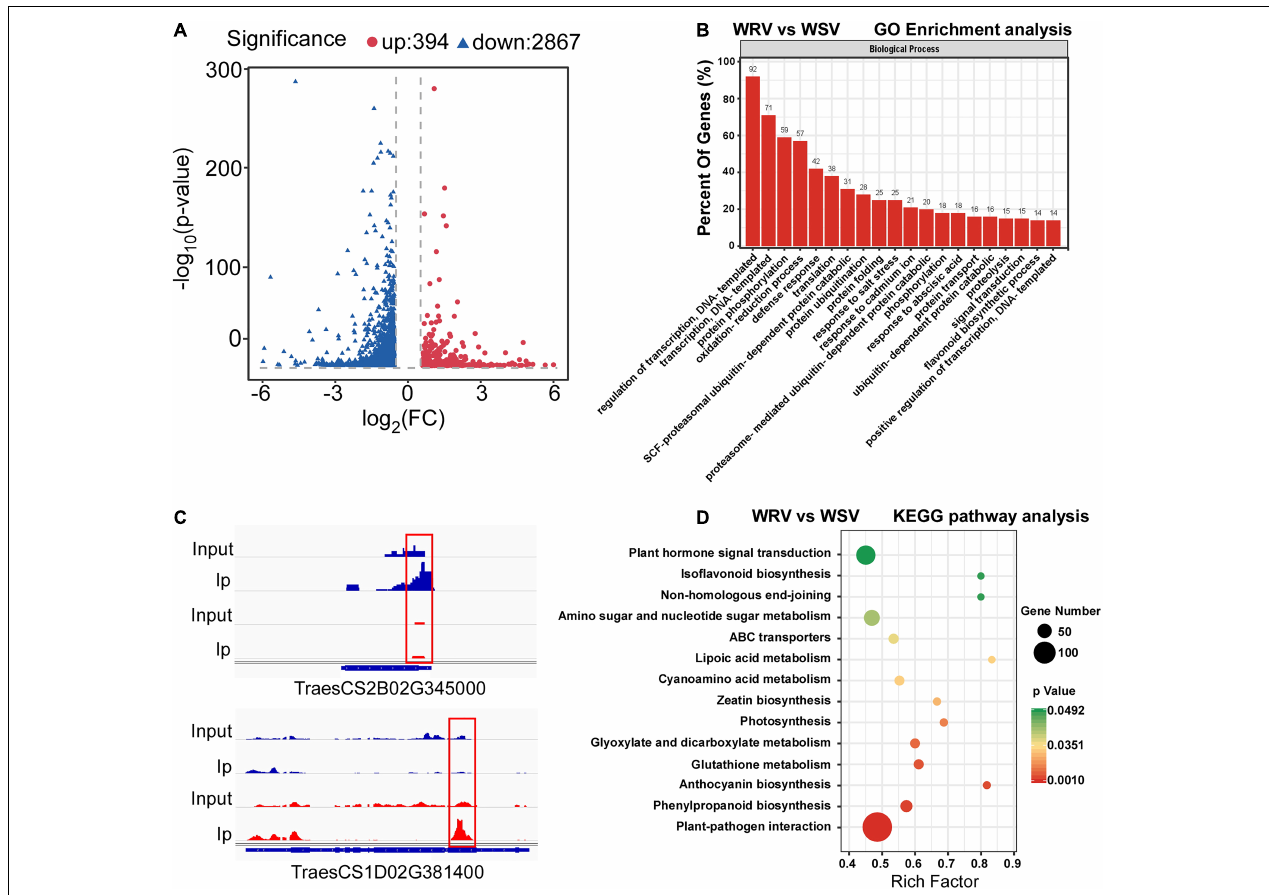
FIGURE 2 | Global m 6 A modification changes in two WYMV-infected varieties and functional analysis of genes with m 6 A. (A) Identification of 394 hyper-methylated and 2867 hypo-methylated m 6 A peaks in the WRV group compared with the WSV group that showed a significant increase or decrease in m 6 A methylation (fold change > 1.5, p < 0.05). (B) Examples of hyper-methylated and hypo-methylated genes with differential m 6 A peaks. The blue peaks represent the IP and Input reads from the WRV group, and the red peaks represent the IP and Input reads from the WSV group. The red boxes represent m 6 A peaks. (C) Gene Ontology analysis of biological processes of differentially methylated genes (DMGs). The vertical axis represents the proportion of DMGs enriched in each pathway. (D) KEGG pathway enrichment analysis of the DMGs. The horizontal axis represents the rich factor of each pathway.